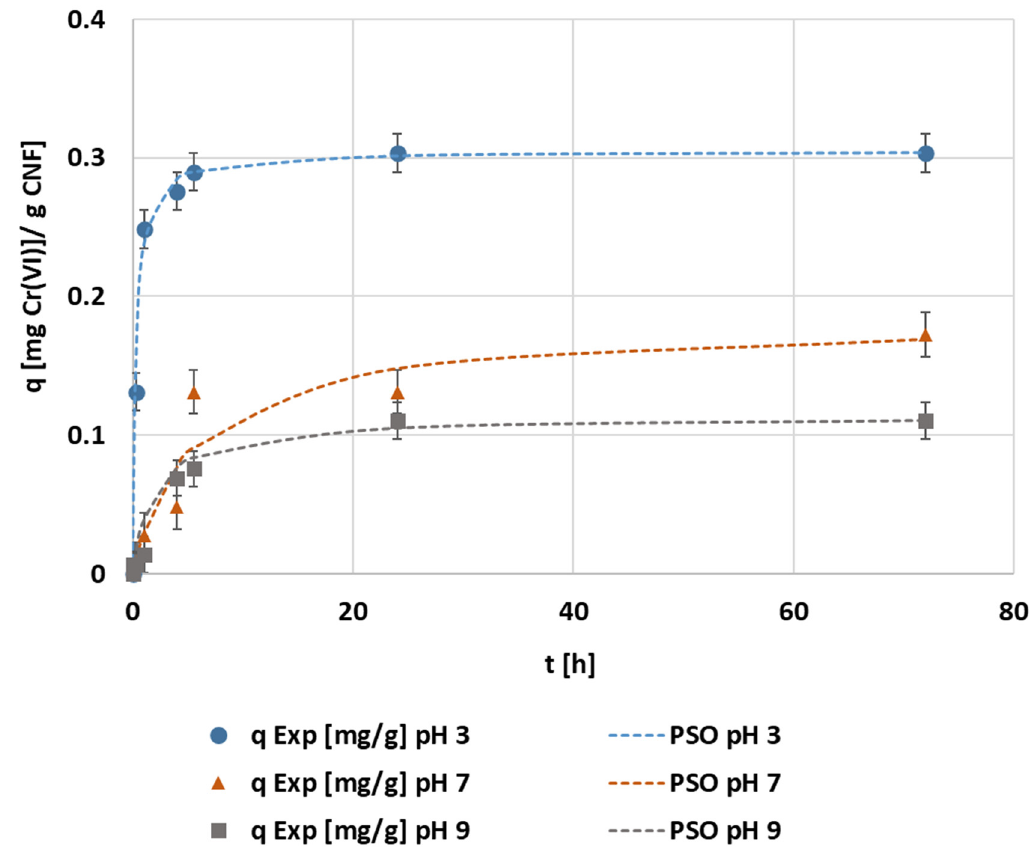
Figure 6. The evolution of the kinetic adsorption experiment at 0.1 mg·L − 1 of the initial chromium concentration, 1.5 mmol MTMS·g − 1 CNF applied during hydrophobization, and 1000 mg CNF·L − 1 of dosage under different pH and kinetic fitting of the pseudo-second order model.